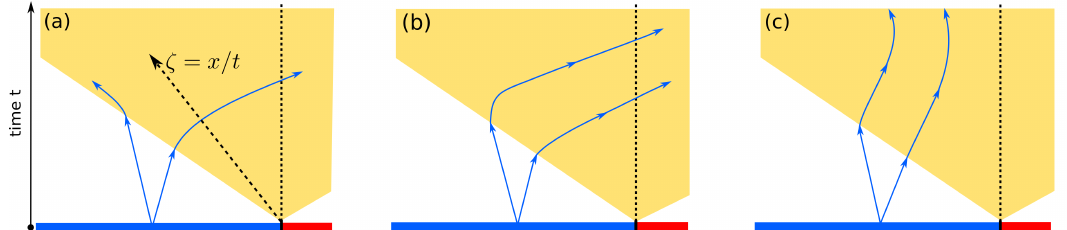
Figure 4: Possible trajectories of the entangled quasiparticles after a quench from piecewise homogenous initial state. Quasiparticle pairs are produced deep in the bulk of the two subsystems, with opposite velocities. The shaded area denotes the lightcone spreading from the interface between the two systems (vertical dotted line). Quasiparticles trajectories are linear until they hit the lightcone. Within the lightcone the quasiparticles velocities depend on the ray ζ ≡ x / t . Panels (a)–(c) show the three possible trajectories of the quasiparticle pairs produced on the left of the junction. (a) Only one member of the pair reaches the interface. (b) Both members of the pair reach the interface at different times. (c) Both members are deflected back before reaching the